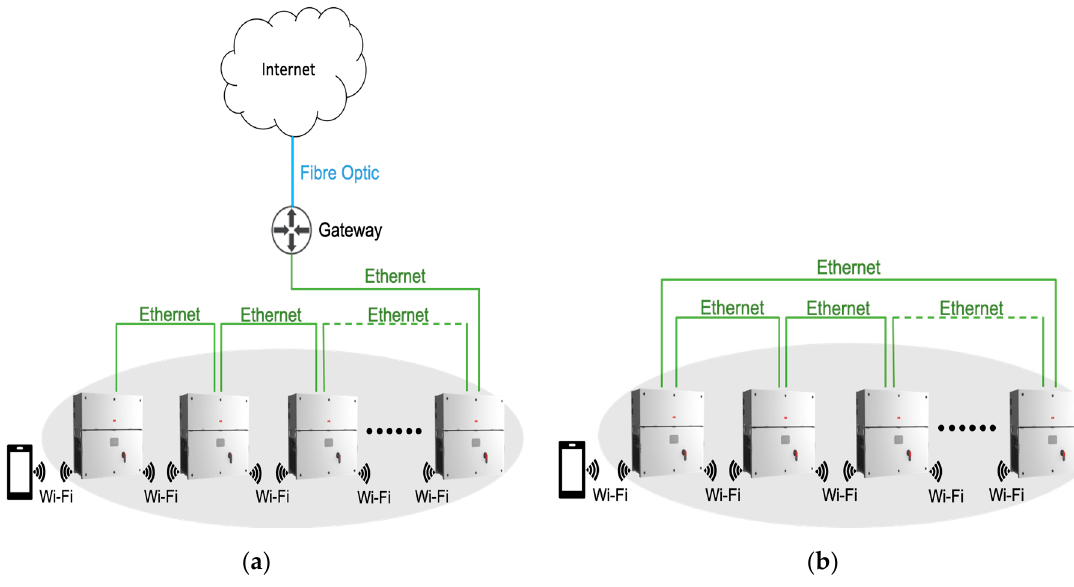
Figure 3. System model: ( a ) Internet-connected PV plant and ( b ) Internet-disconnected PV plant.